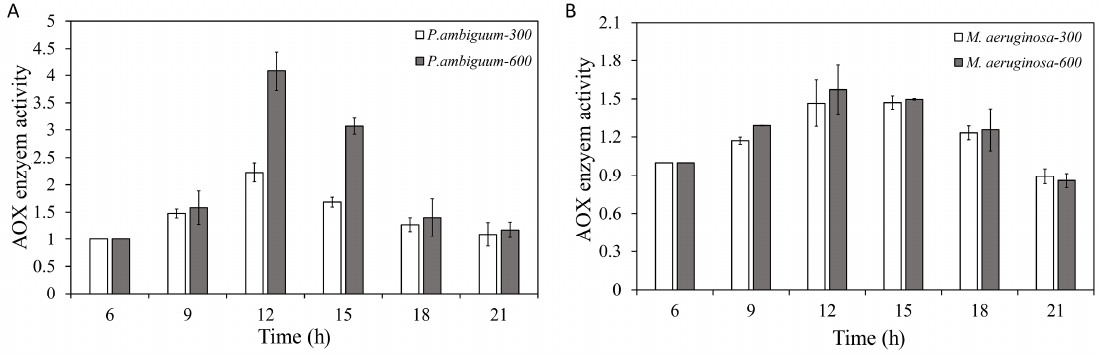
Figure 6. Diurnal variations in the total antioxidant (AOX) activity of P. ambiguum (strain NIES 2119) ( A ) and M. aeruginosa (strain NIES 111) ( B ). The numbers 300 and 600 represent the maximum PAR intensities (in µ mol · m − 2 · s − 1 ) for two di ff erent treatment conditions, where the maximum PAR intensity was reached at 12:00 h. The error bars represent the standard deviations.